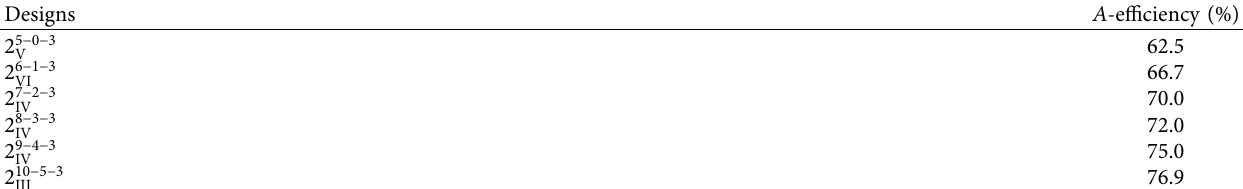
Table 8: Design efciency design and block generators for m � 5, 6, 7, 8, 9, and 10 with 8 choice sets of size 4.